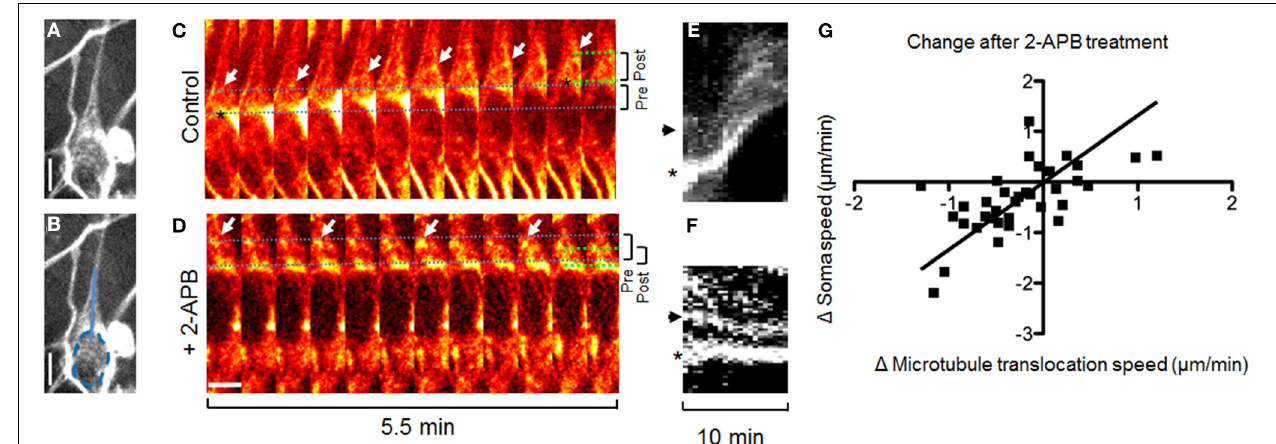
FIGURE 3 | Inhibiting IP3 receptors reverses forward translocation of microtubules. (A,B) Fluorescent staining of microtubules in a migrating GnRH neuron. (B) Same as (A) , but with a dotted line s howing the border of the nucleus and a solid line showing the region shown for kymographs. (C,D) Forward translocation of microtubules ( C , arrows) is reversed after application of 2-APB to block IP3 receptors ( D , arrows). Dotted lines show the distance between the soma edge and microtubule bundles at the beginning (blue) and end (green) of the imaging session;